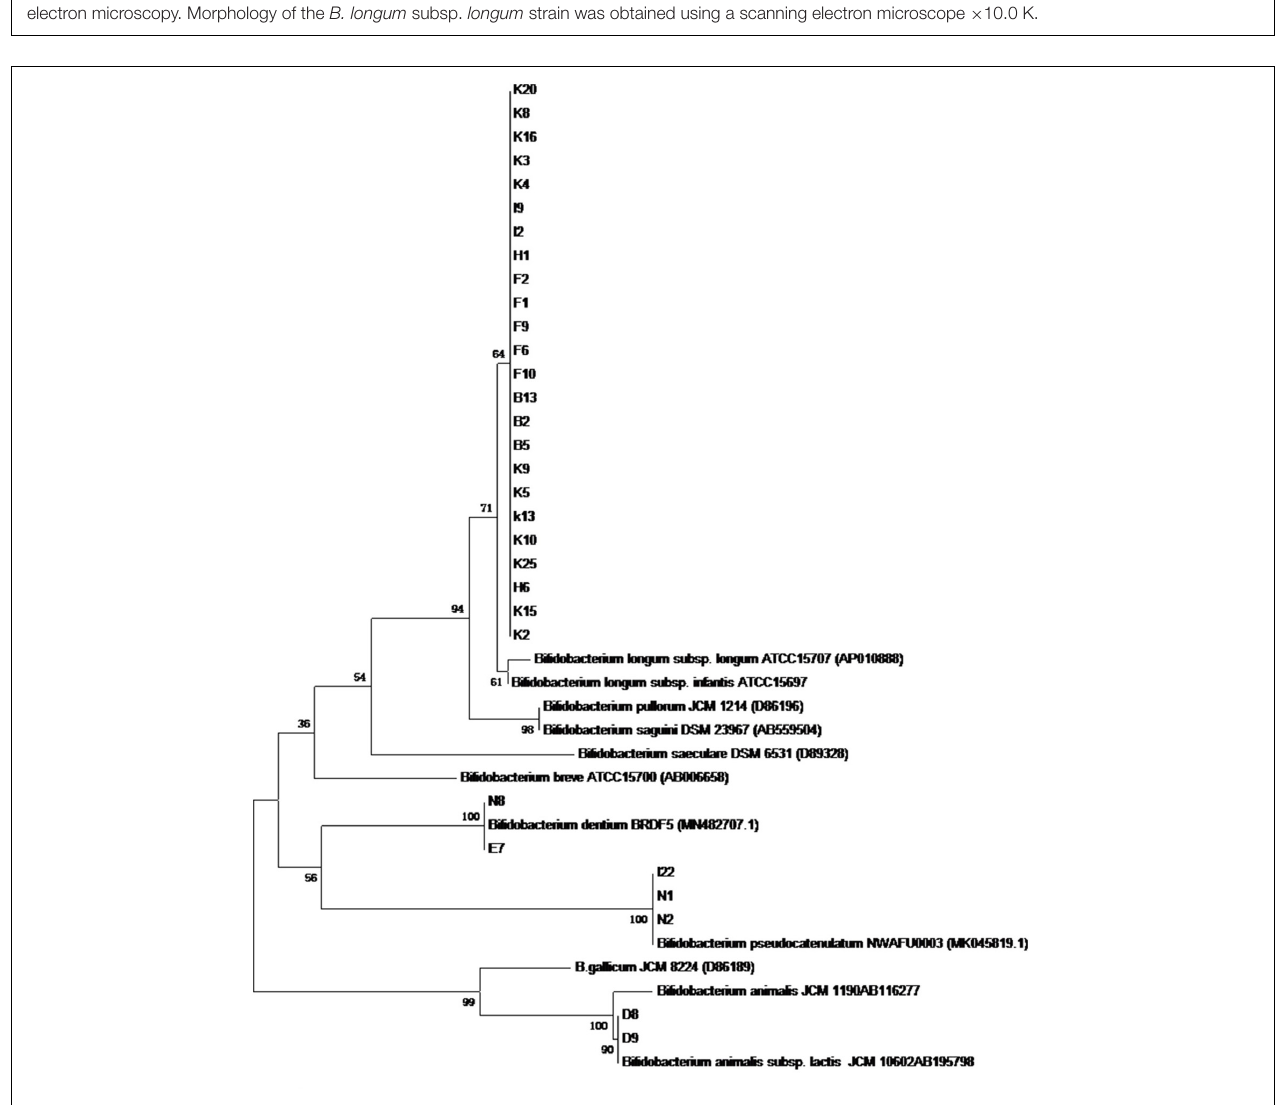
FIGURE 2 | The phylogenetic tree based on 16S rRNA genes for 31 Bifidobacterium stains isolated from infant feces.